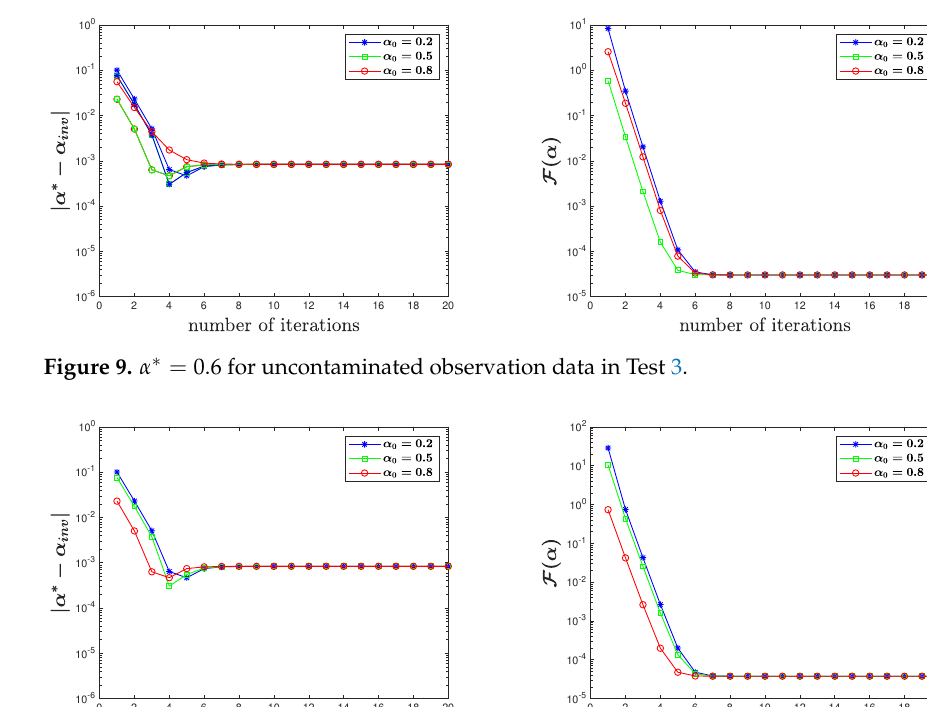
Figure 8. α ∗ = 0.3 for uncontaminated observation data in Test 3.